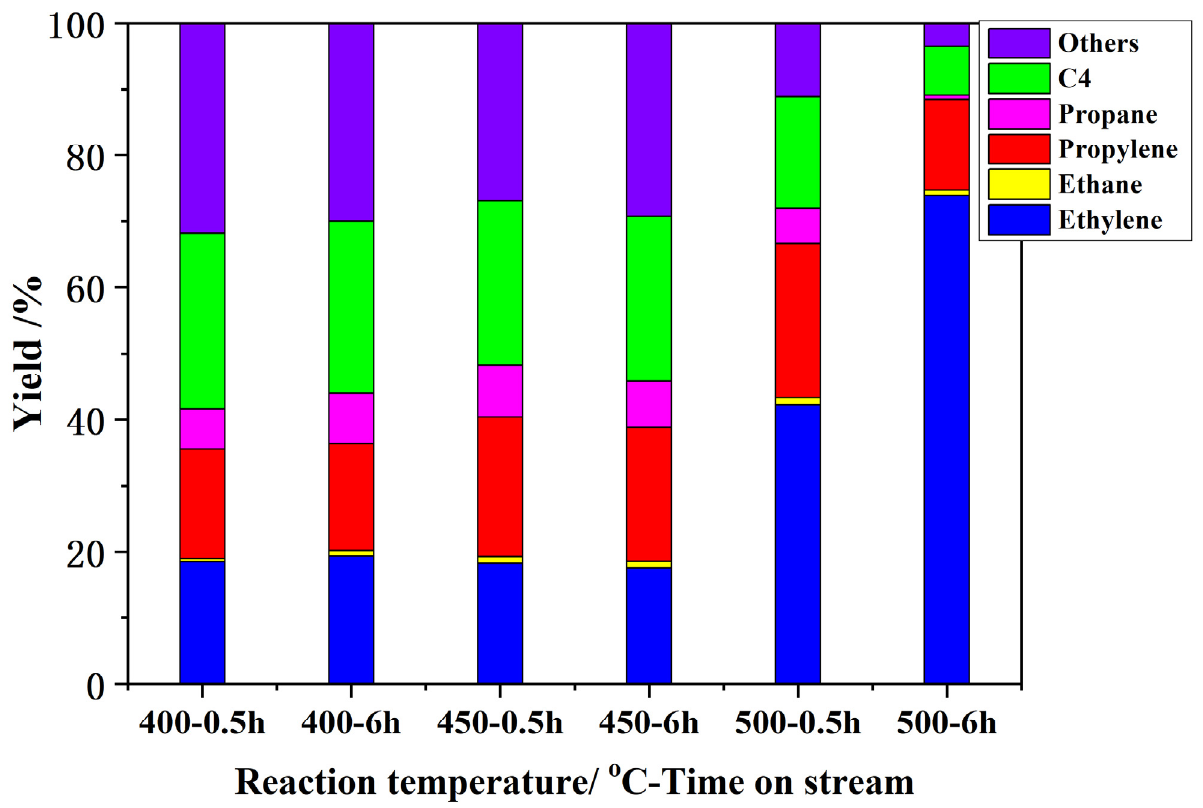
Figure 5. ETO reactions at different temperatures and under different reaction times over H-ZSM-5(80) catalyst. W/F = 0.0025 g/cm 3 ·min − 1 , EtOH concentration, 50%.